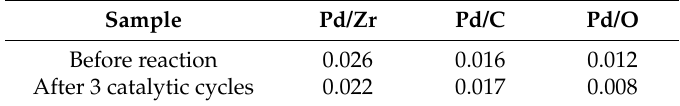
Table 4. Effect of number of catalytic cycles on specific surface area of Pd.